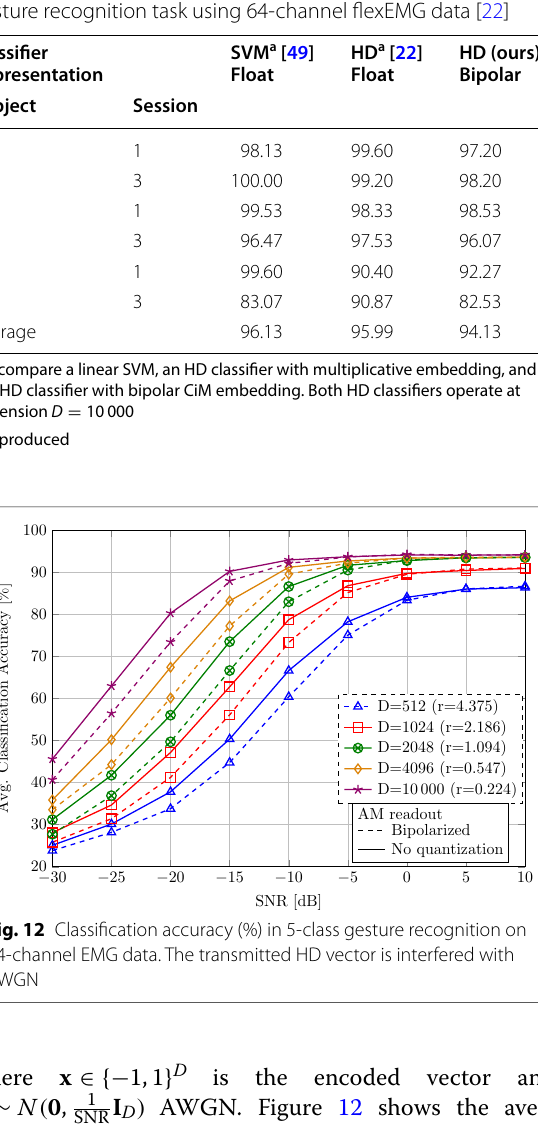
Table 1 Classification accuracy (%) on 5-class EMG-based